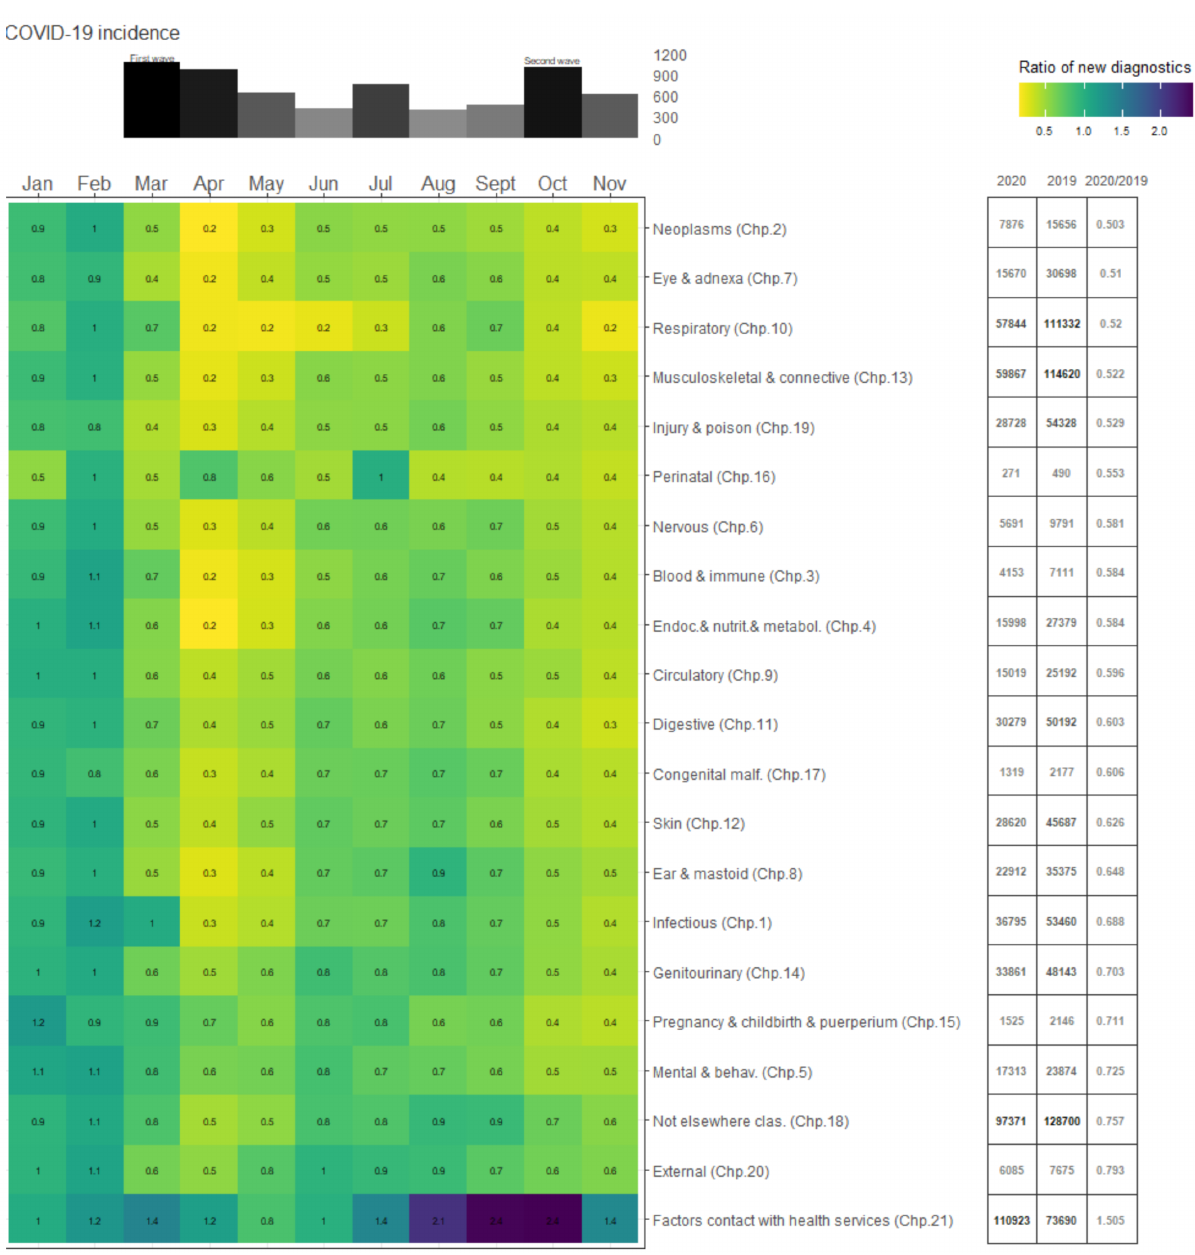
Figure 1. The heatmap presents, by month (x-axis), the ratio of new diagnoses in 2020 compared to new diagnoses in 2019, by ICD-10 groups (y-axis). Numerical values for the monthly ratios are provided for each month and ICD-10 group. Severe drops in diagnoses in 2020 are more yellow, similar diagnoses are in deep green, while increases in diagnoses are in purple. Monthly COVID-19 incidence per 100,000 for the region is plotted above the heatmap. The three columns to the right of the heatmap present counts of diagnoses by ICD-10 group in 2020, 2019, and the ratio of 2020/2019,